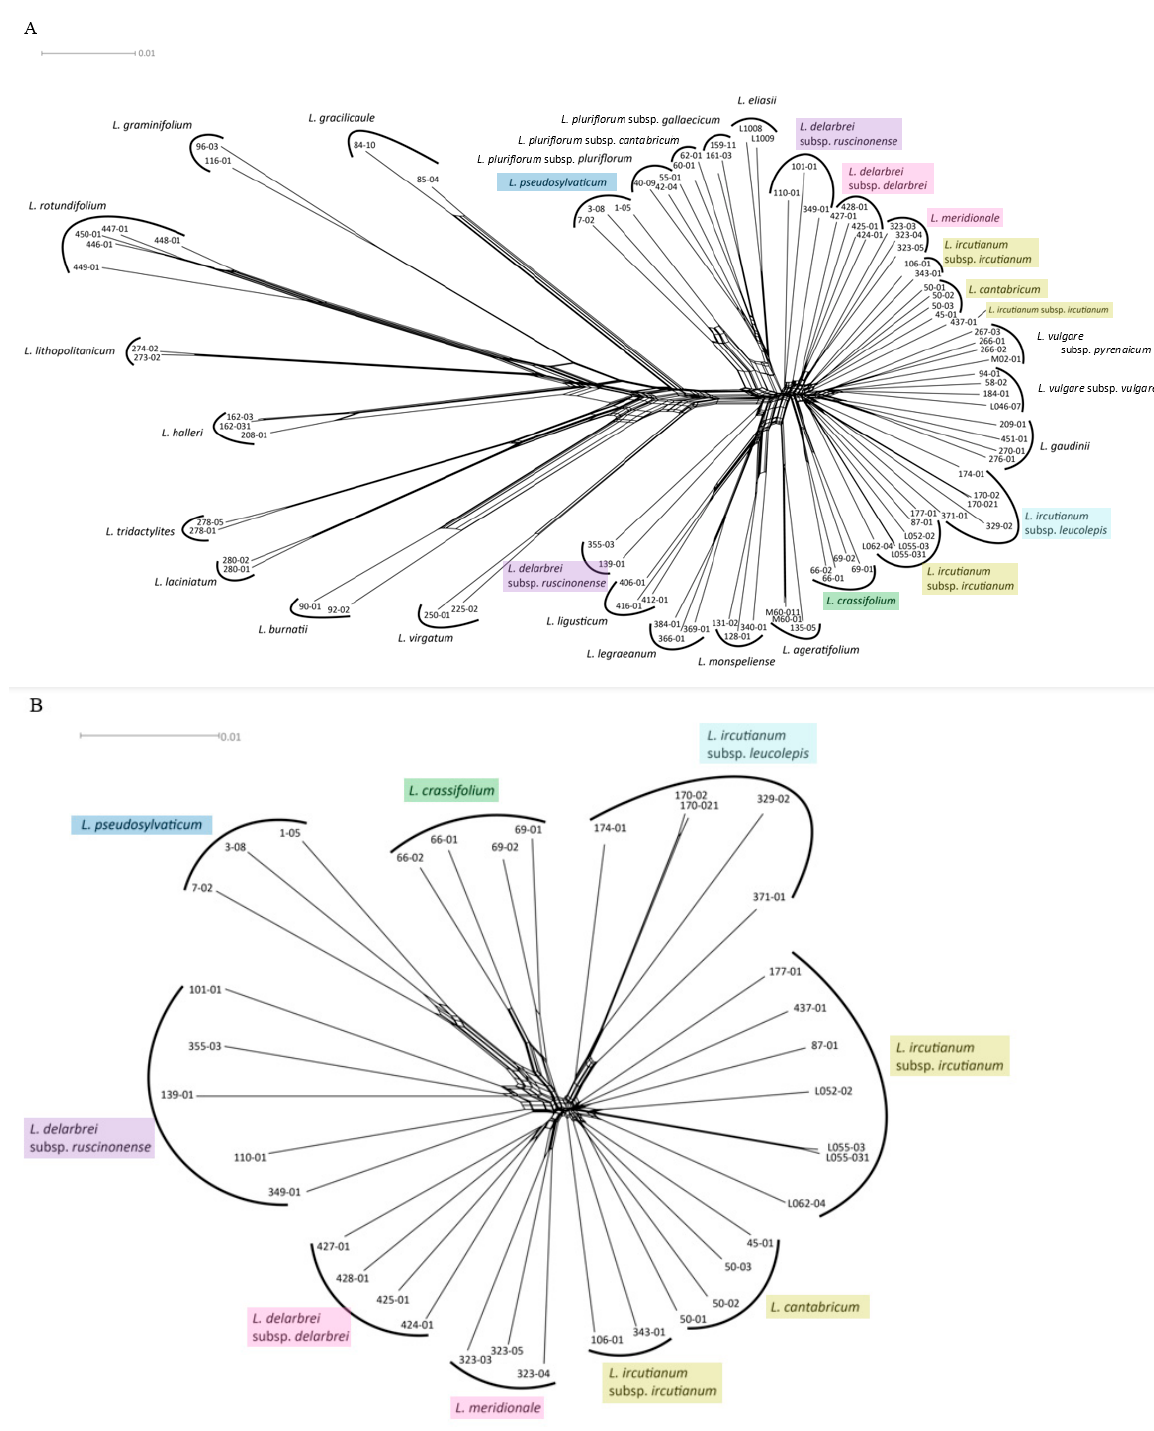
Figure 2. NeighborNet network reconstructions based on SNP-level Nei distances of the full dataset ( A ), comprising individuals from all 17 diploid species and eight tetraploid taxa (in coloured boxes), and of the tetraploids only ( B ). For the full dataset, all tetraploid taxa are found within the so-called L. vulgare -group (right). The L. vulgare- group is separated from the remaining diploid species by relatively long branches (center). All diploid samples are clustered according to their species membership ( A ). The same is the case for the tetraploid taxa, except for L. ircutianum subsp. ircutianum , which is separated into two groups (( B ), lower right).